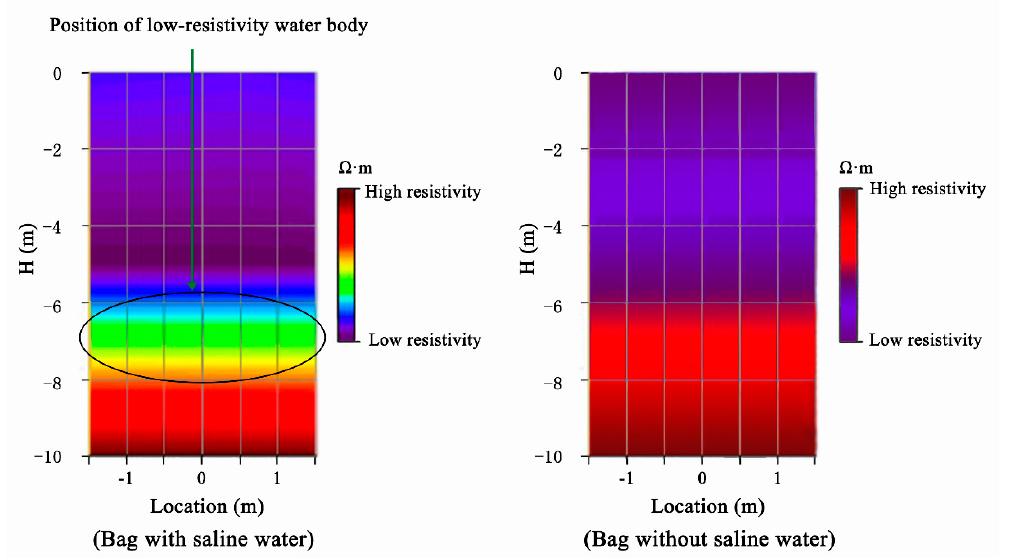
Figure 16. Apparent resistivity map of laboratory experiment measure results.